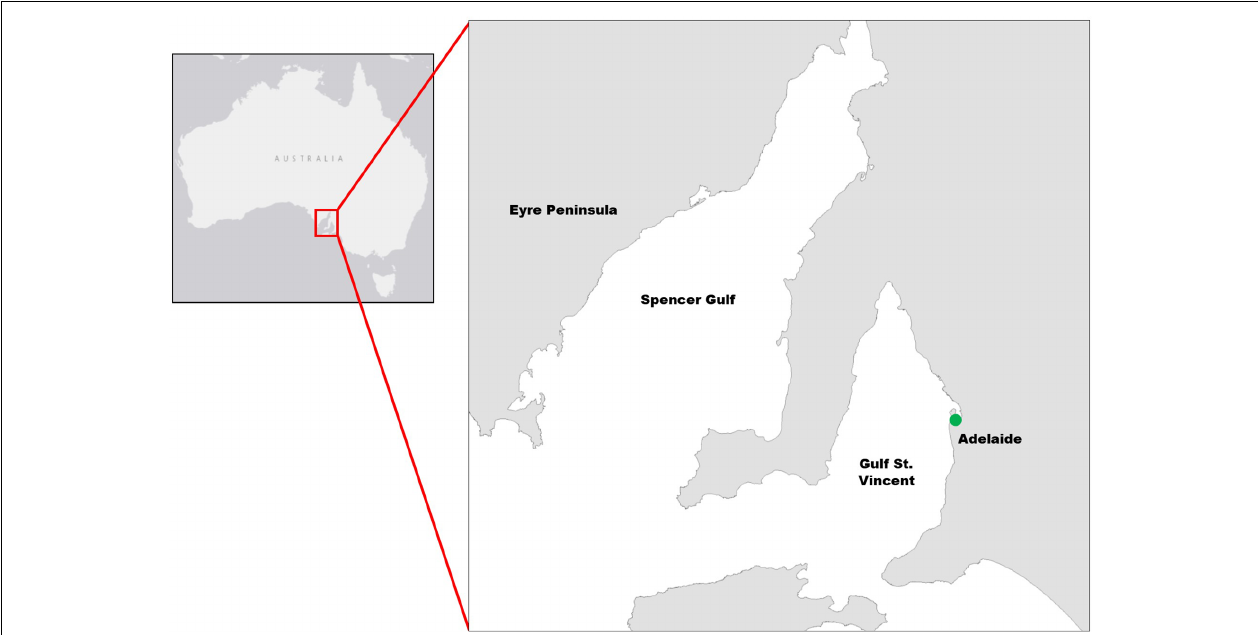
FIGURE 1 | Map of survey and sampling location at North Arm Creek (indicated by green dot), north of Adelaide in South Australia (approximate site location: –34.8245,